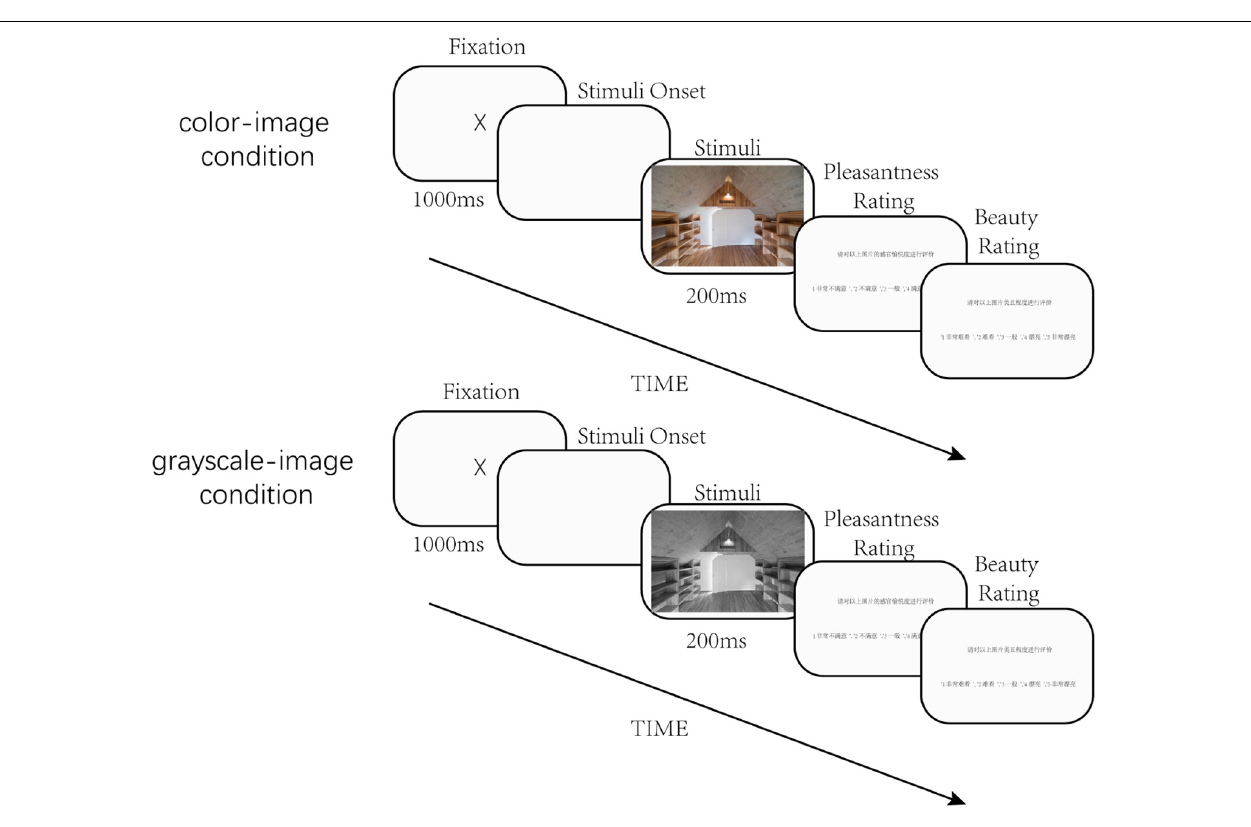
FIGURE 2 | Illustration of the experimental